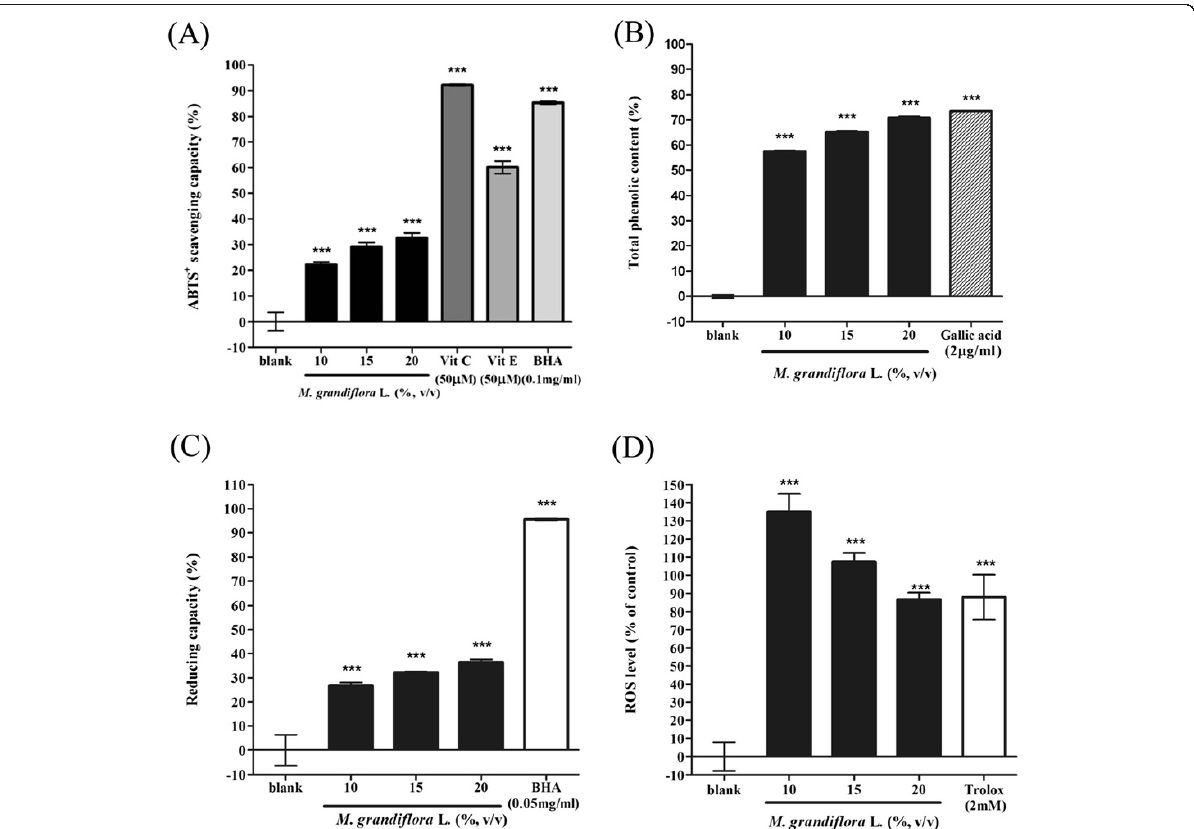
Figure 4 Antioxidant activities of M. grandiflora L. flower extract. ( A ) ABTS + radical scavenging capacity assay. The flower extract (10, 15, 20%; v/v), vitamin C (50 μ M), vitamin E (50 μ M) or BHA (0.1 mg/ml) were incubated with ABTS + solution, respectively. ( B ) Determination of total phenolic content. Different concentrations of the M. grandiflora flower extract (10, 15, 20%; v/v) and gallic acid (2 μ g/ml) were used in the assay. ( C ) Reducing capacity assay. Different concentrations of the flower extract (10, 15, 20%; v/v) or BHA (0.05 mg/ml) were used in the test. ( D ) Determination of ROS content in B16F10 cells. Cells were treated with various concentrations of the flower extract (10, 15, 20%; v/v) or Trolox (2.0 mM) for 24 h and then the ROS content was measured by the DCF-DA assay. Results are represented as percentages of control, and the data are mean±S.D. for three separate experiments. Values are significantly different by comparison with control. *** p <